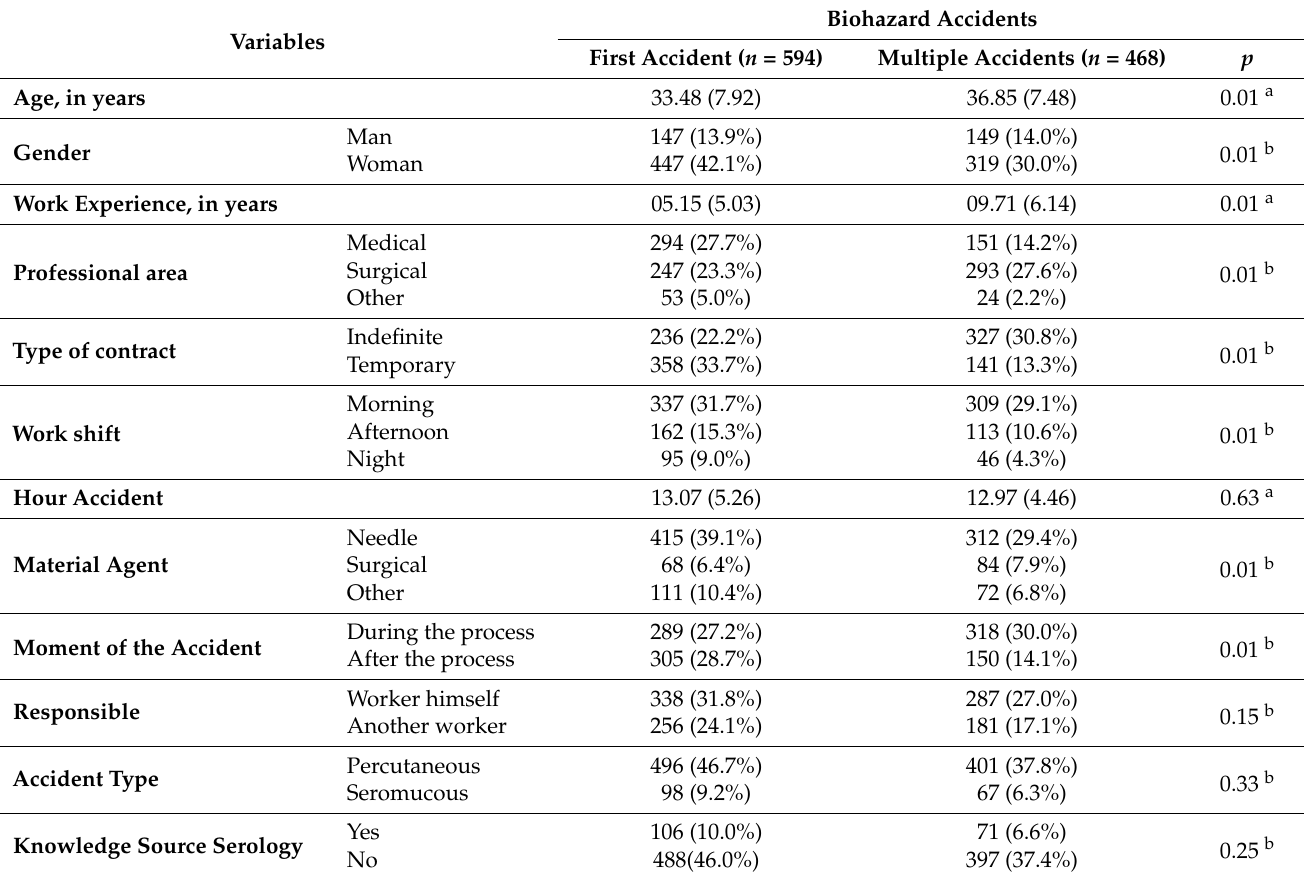
Table 1. Association between number of biohazard accidents and possible risk